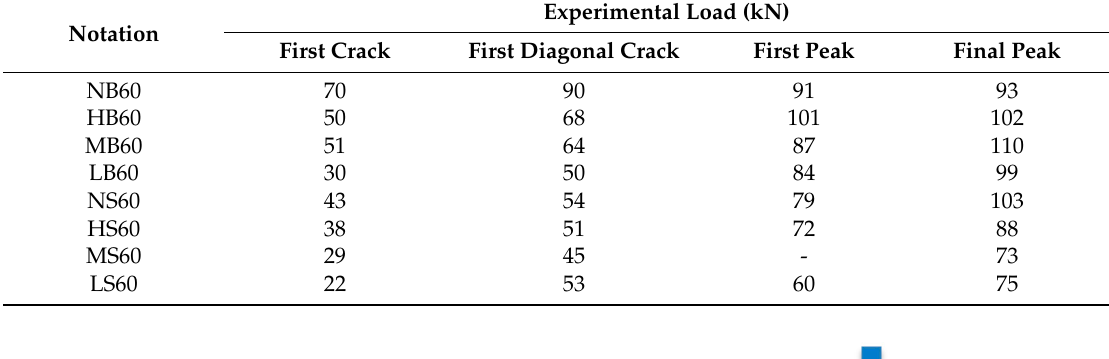
Figure 15. Bond stress-slip relationship of the concrete with a 19-mm-diameter steel rebar with different water-to-cement ratios. ( a ) For w/c = 0.75; ( b ) for w/c = 0.60; ( c ) for w/c = 0.45; ( d ) for w/c =